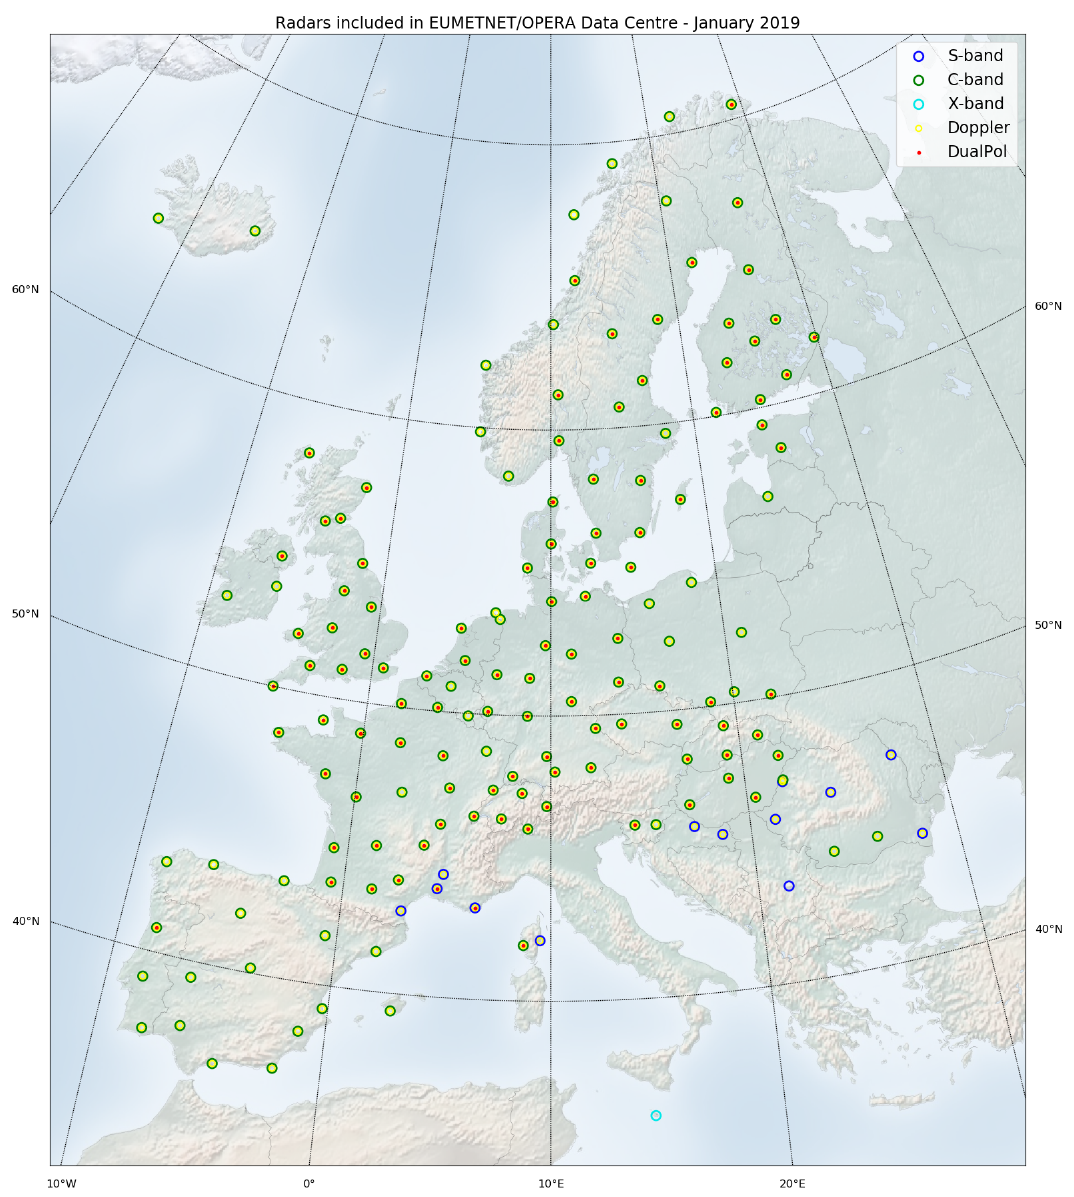
Figure 1. Location and type of radars included in the Operational Program for Exchange of Weather Radar Information (OPERA)